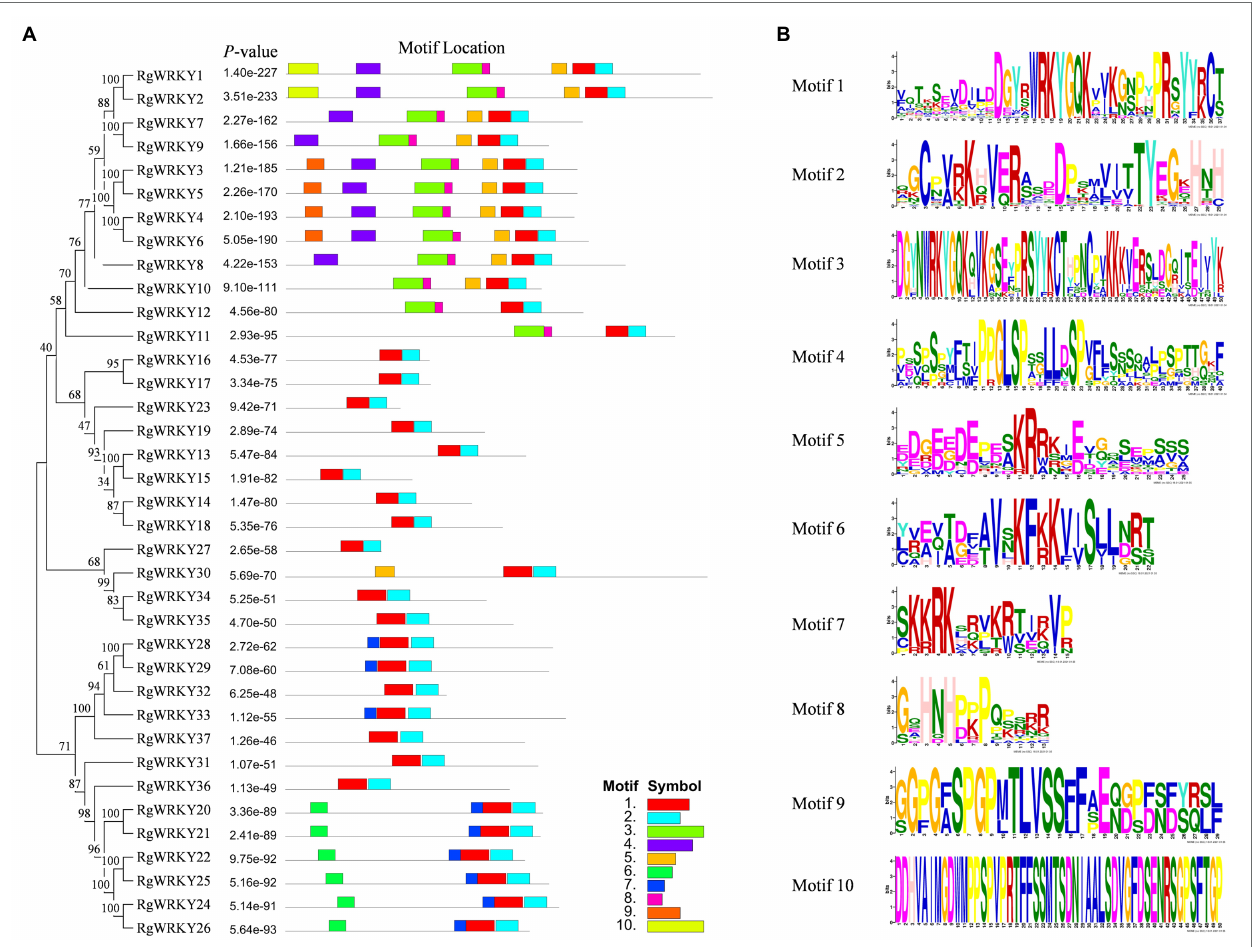
FIGURE 2 | Phylogenetic clustering and conserved protein motifs of RgWRKY genes. (A) Phylogenetic relationships and motif compositions of RgWRKY members. The phylogenetic tree was constructed with the full-length sequences of R. glutinosa WRKY proteins using MEGA v6.0. (B) Ten types of conserved motifs in R. glutinosa . The conserved motifs were predicted using the MEME